Question: What does this figure show? Answer in one sentence.
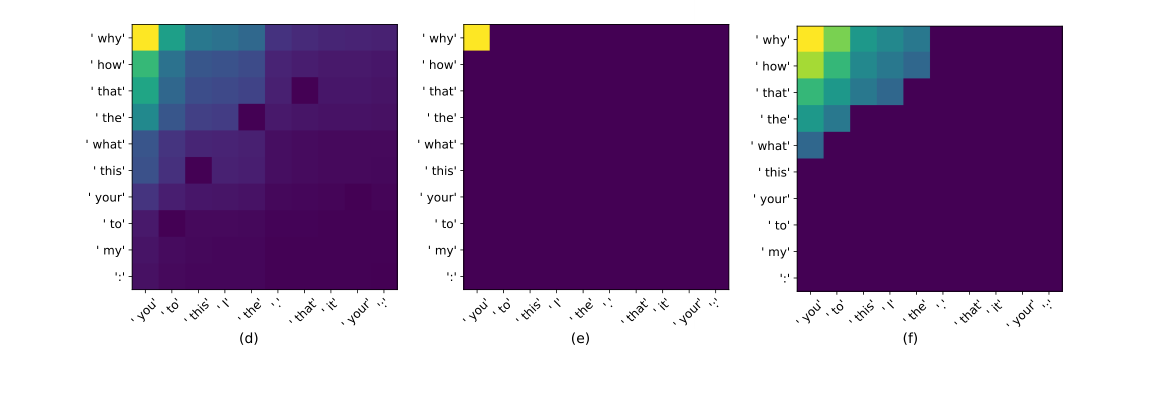
Answer: Joint probability distribution with top 10 tokens sorted in decreasing order of probabilities using the DynaMo-2.9B-T2 model for the input prompt: Please explain. Probabilities corresponding to repetition have been penalized by a factor of 100. (a) and (d) are vanilla distributions. Co-occurrence masked distribution with (b) αc = 0.5 [CO-0.5] and (c) αc = 1.0 [CO]. Adaptive thresholding (e) without Gaussian blur [AT], and (f) with Gaussian blur (kernel size = 3) [AT + G-3].